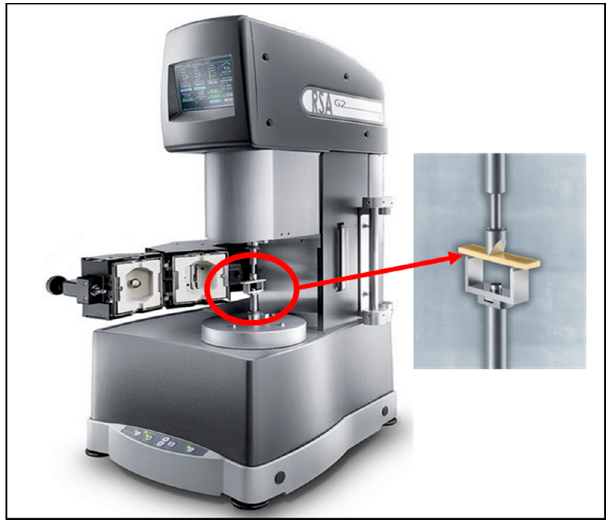
Figure 1. Dynamic mechanical Analyzer for three-point bending creep Analysis.